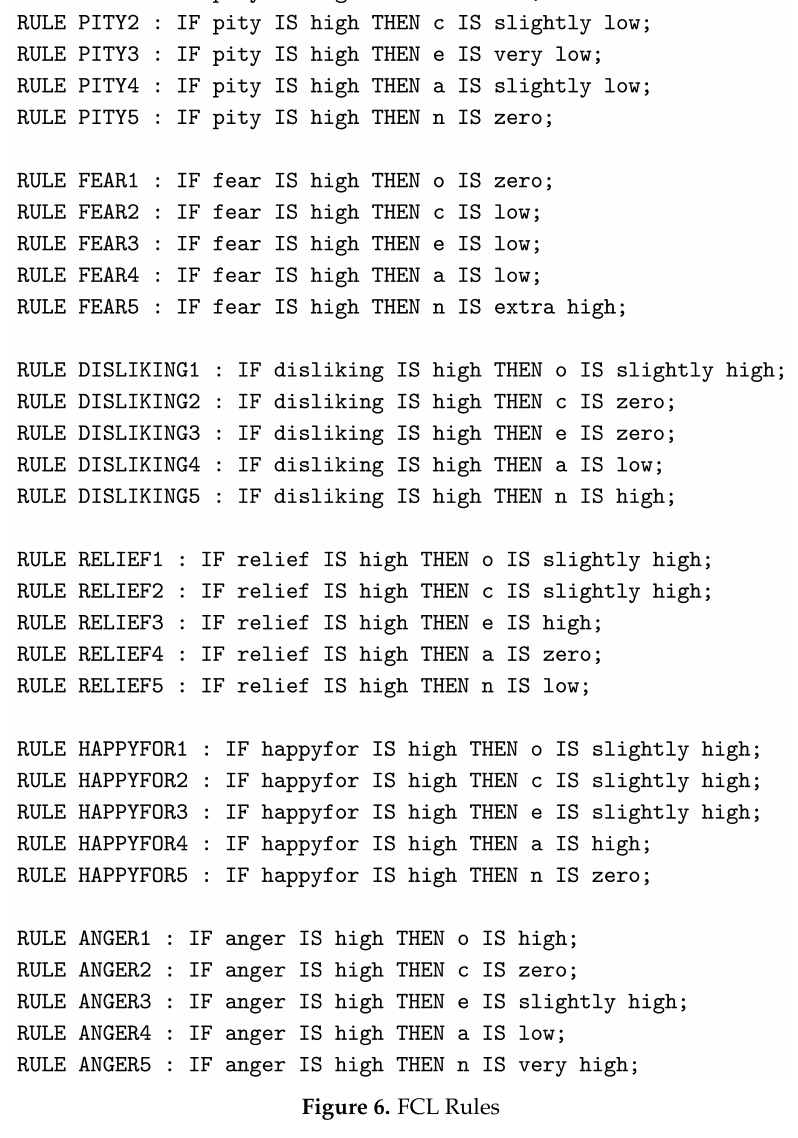
Figure 6. FCL Rules